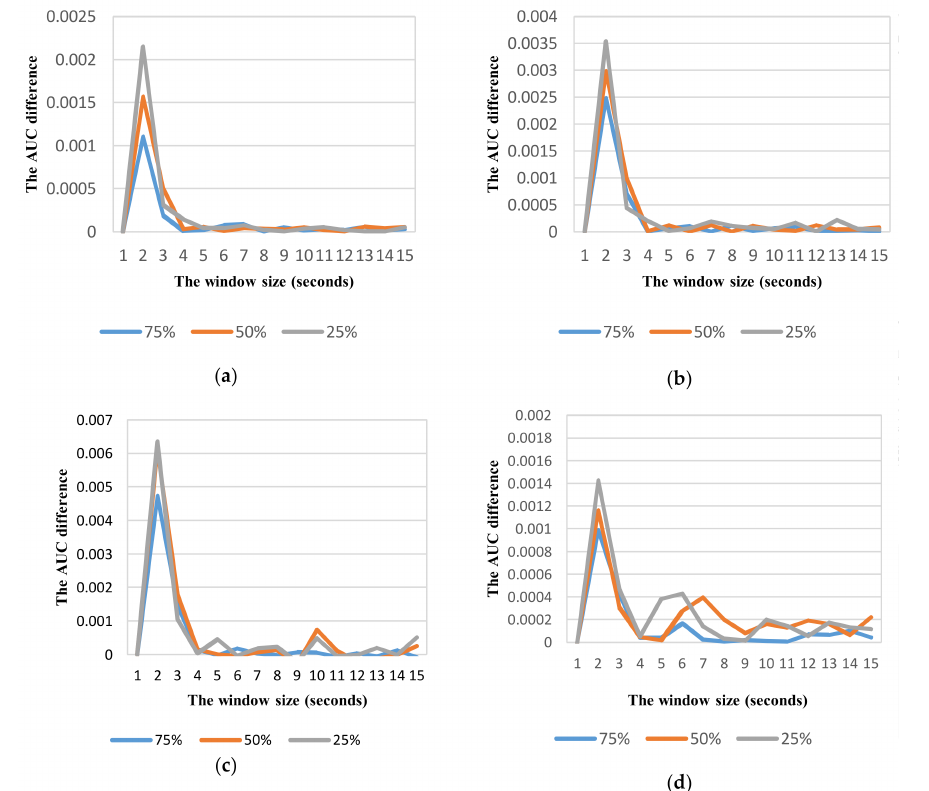
Figure 8. Variation of AUC difference between two consecutive window sizes at different overlapping ratios for different vehicle detection: ( a ) Car; ( b ) Motorbike; ( c ) Bus; ( d ) Walking (Non-vehicle).